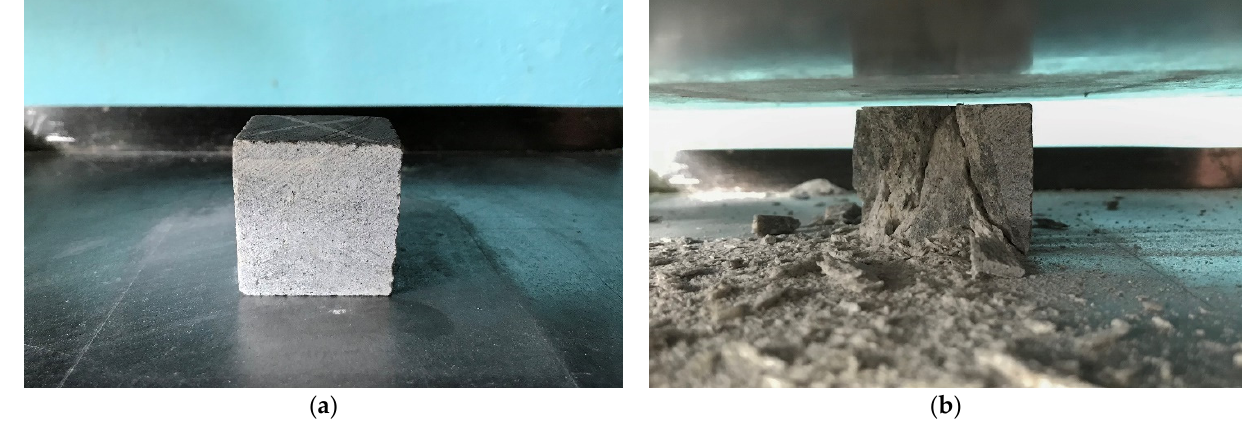
Figure 2. Aerated concrete sample: ( a ) before compression test; ( b ) after compression test. The value of the coefficient of constructive quality ( CCQ ) was determined by the for- mula: